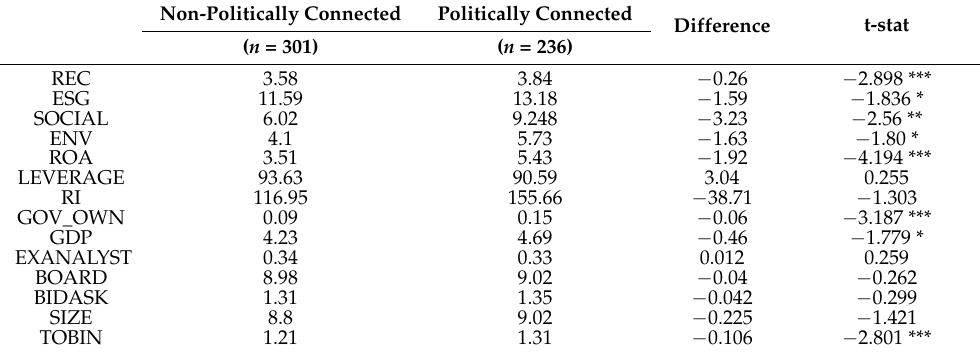
Table 3. T-test between politically connected versus non-politically connected firms.